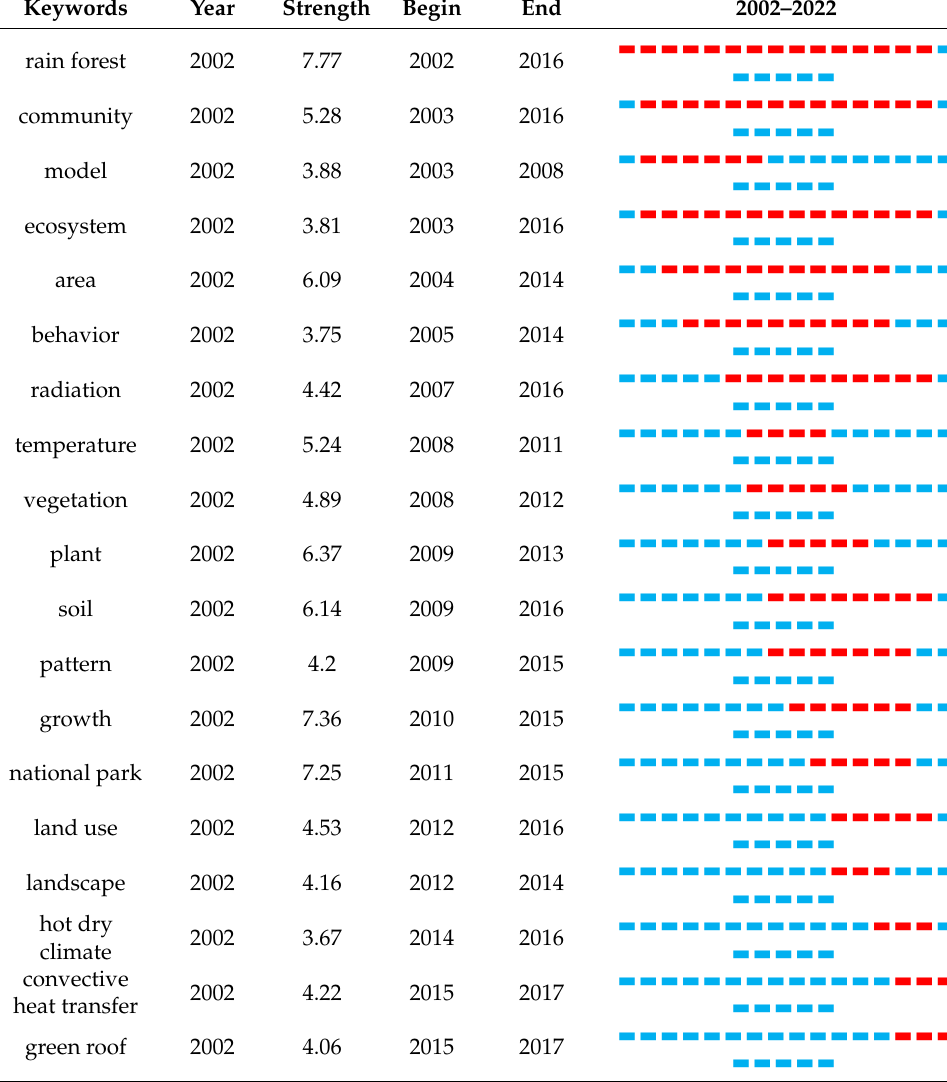
Table 4. Keyword bursting information table for foreign landscape microclimate research. Keywords Year